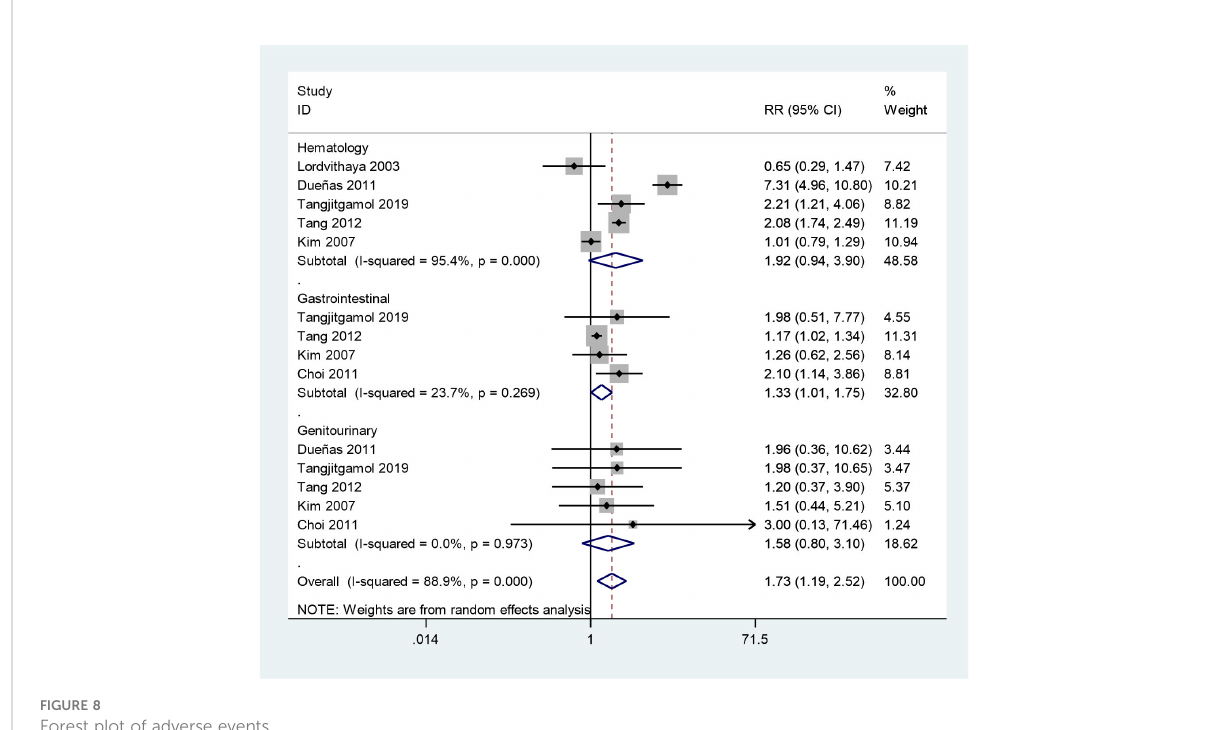
FIGURE 8 Forest plot of adverse events.